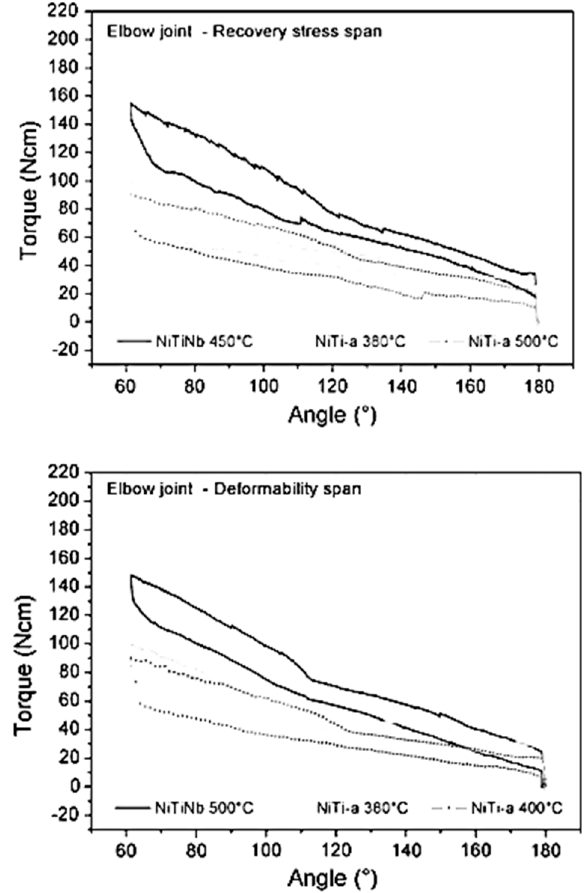
Figure 12. Torque–angle curves for the hinges mounting several different pseudoelastic springs. The left graph shows curves for a selection of hinges with pseudoelastic elements ranging across recovery stress levels; the right graph displays hinge properties for pseudoelastic elements spanning the plateau lengths [33].